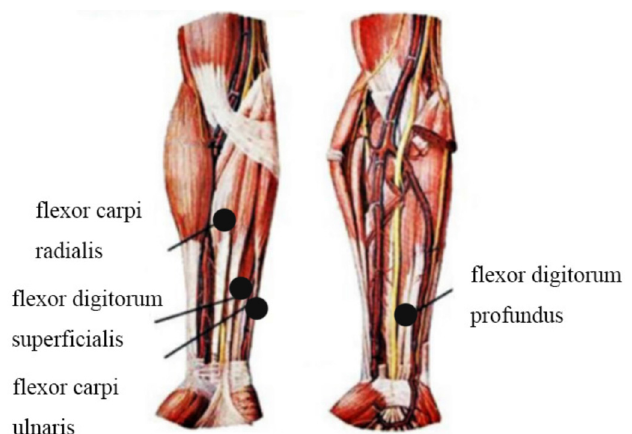
Fig. 3. Sensor pasting